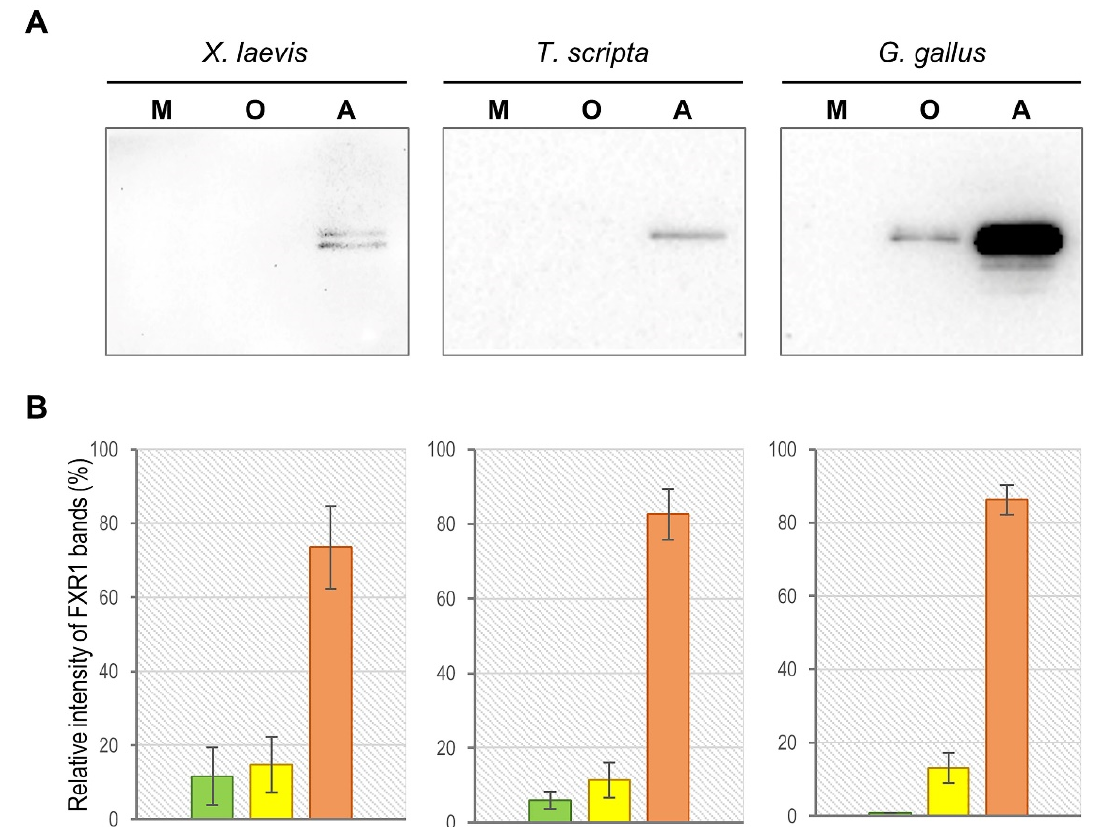
Figure 1. FXR1 forms SDS-resistant amyloid-like aggregates in the brains of Xenopus laevis , Trachemys scripta, and Gallus gallus domesticus . ( A ) FXR1 is predominantly found as insoluble aggregates in all vertebrate species studied. Total protein lysate from the brain was treated with 1% SDS and separated into three fractions: of monomers less than 100 kDa (M), oligomers larger than 100 kDa (O), and insoluble aggregates (A). The fractions were subjected to SDS-PAGE and analyzed by immunoblotting with anti-FXR1 antibodies. ( B ) Relative intensity of bands corresponding to FXR1 monomers, oligomers, and insoluble aggregates is represented as mean ± SEM (standard error of the mean) for three independent brain samples for each organism. The green, yellow, and orange columns of the diagram represent the values for monomers, oligomers, and insoluble aggregates, respectively. 2.2. FXR1 Colocalizes with Amyloid-Specific Dyes Thioflavin S and Congo Red on Cryosections